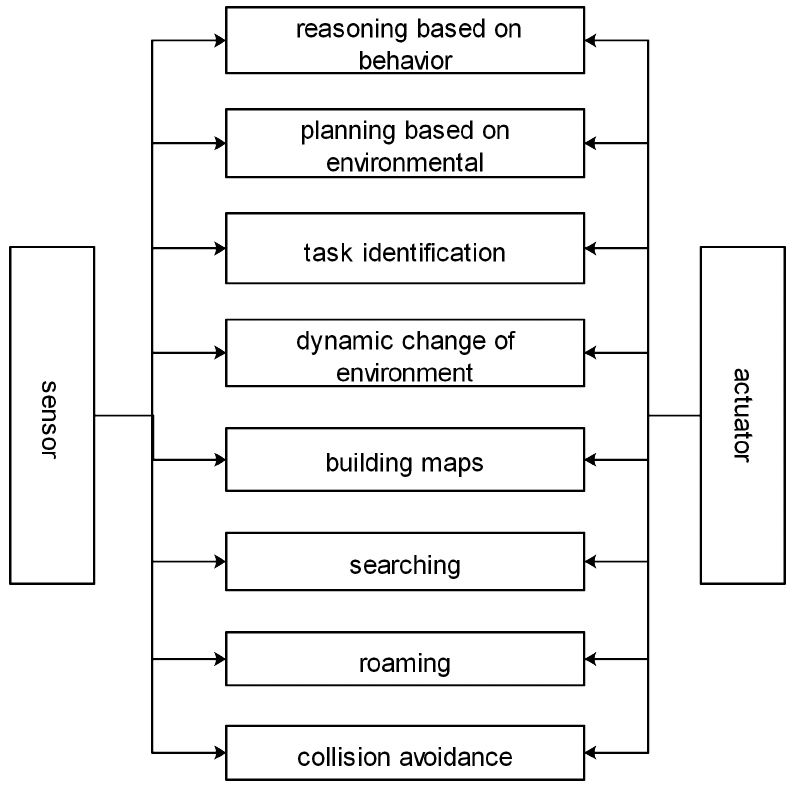
Figure 5. The behavior-based